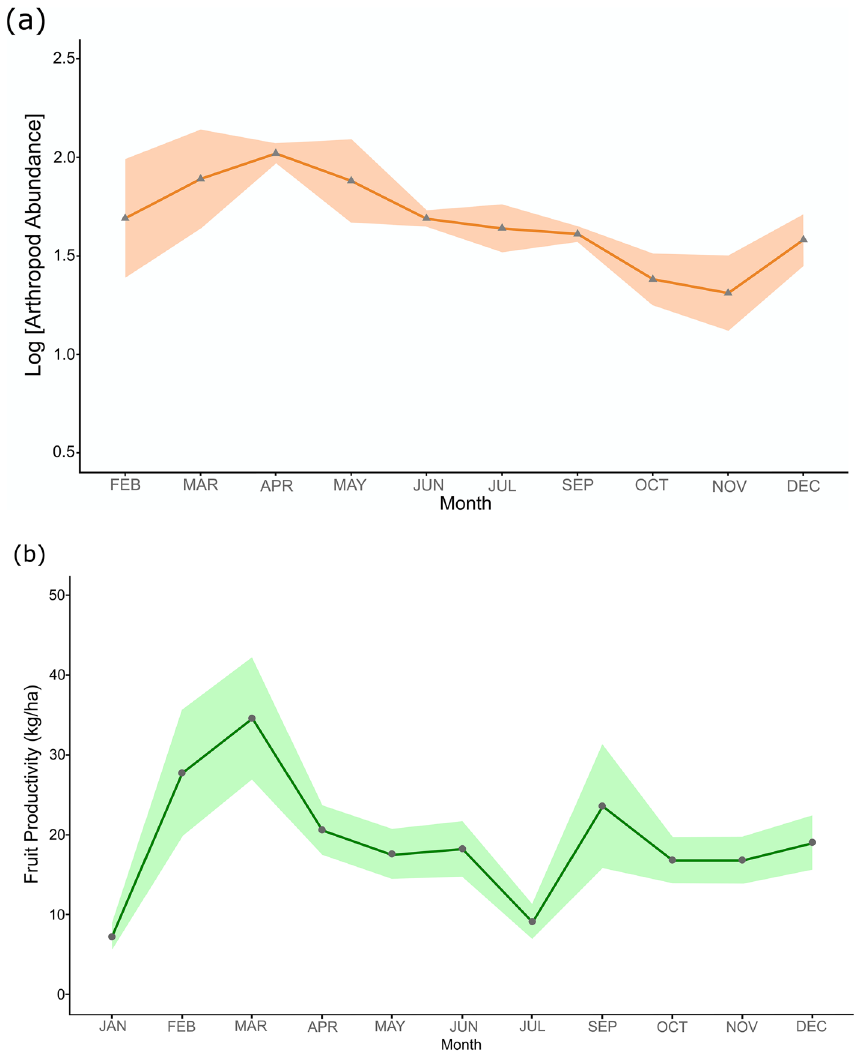
Figure 3. Arthropod and fruit availability at Cueva de los Guácharos National Park. ( a ) Arthropod abundance (orange) over time. In general, availability is quite constant over time and peaks during the first months of the year, experiencing a decrease during the last months of the study. Light orange shadow around each point indicates the standard error. ( b ) Seasonal variation of fruits (green) over time, y-axis shows the mean month fruit productivity in terms of kg/ha. Productivity peaks twice a year during the months of March and September, light green shadow indicates the standard